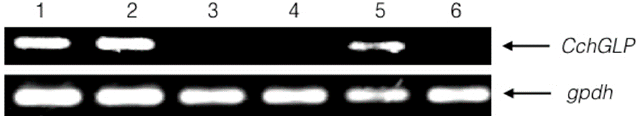
Figure 5. Silencing of CchGLP at 90 dpi in originally inoculated and non-inoculated leaves in C. chinense BG-3821 plants. Lanes 1 and 2 , upper and lower leaves in inoculations with empty viral vector, respectively; Lanes 3 and 4 upper and lower leaves of plants inoculated with silenced vector for CchGLP, respectively; Lane 5 , + control (geminivirus mixed infected BG-3821 plant); lane 6 control (inoculated plant only with empty vector). The housekeeping gene gpdh (encoding glyceraldehyde phosphate dehydrogenase) was used as control.